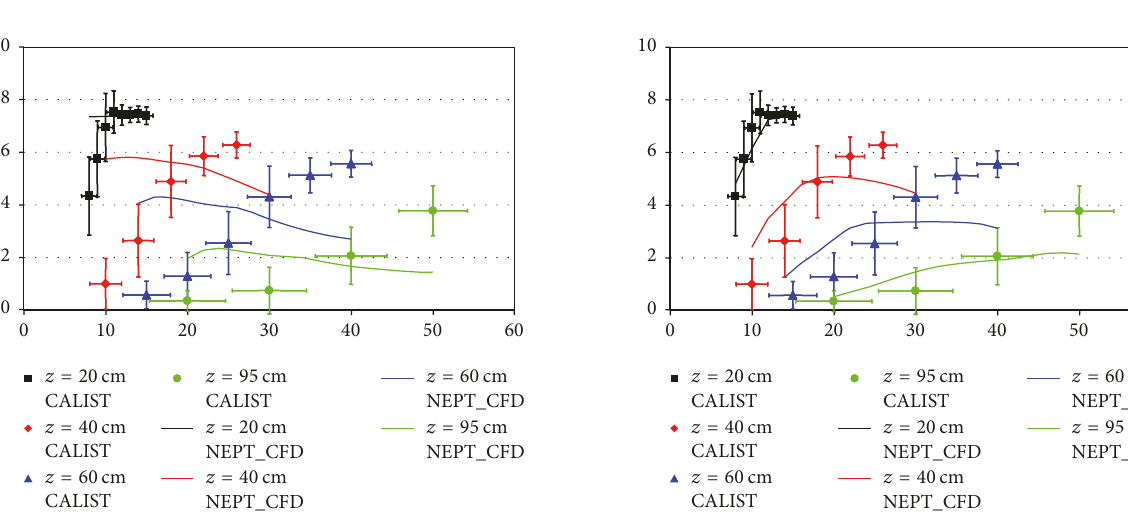
Figure 39: Radial velocity of droplets (m/s) versus radial distance (cm), polydispersed